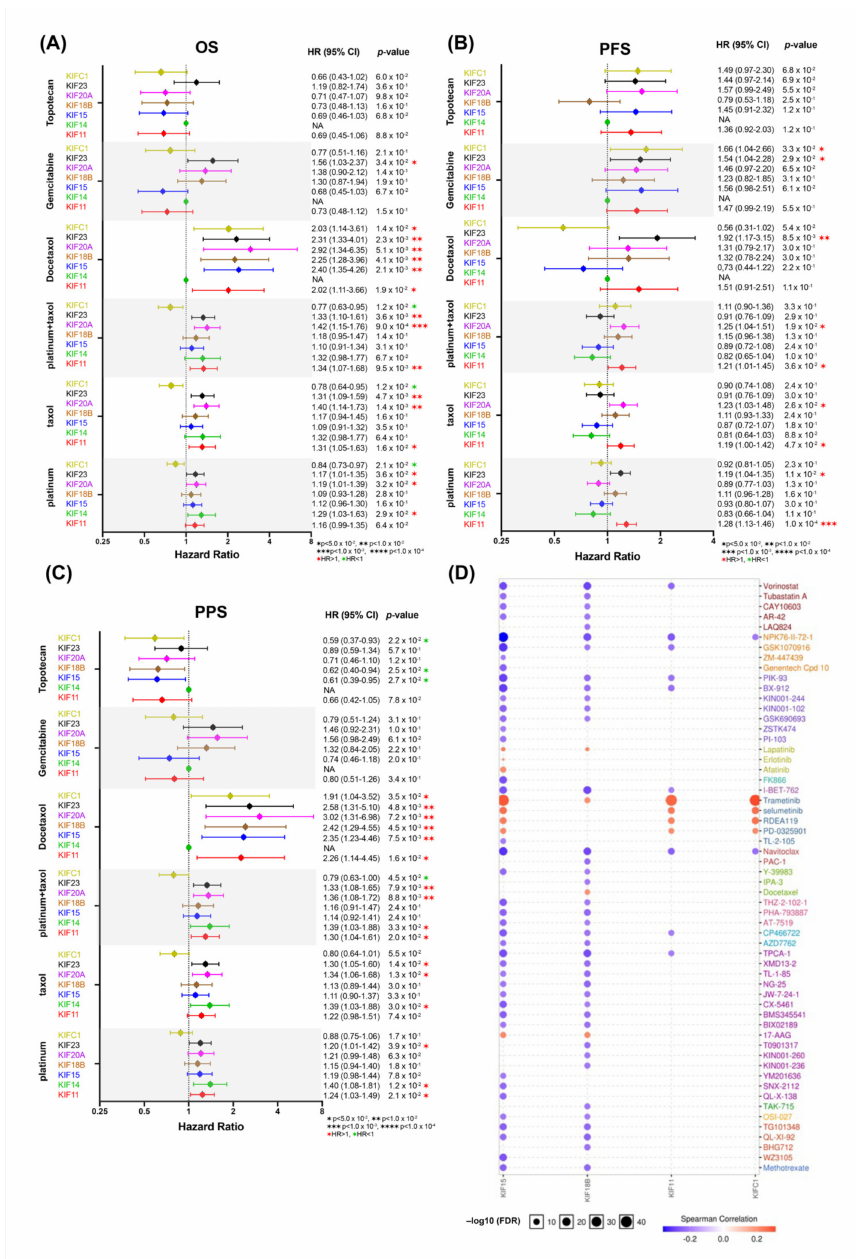
Figure 7. Prognostic values of ten overexpressed mitotic KIFs in OC chemotherapies. Forest plots of relationship between prognosis ( A ) OS, ( B ) PFS, ( C ) PPS, and ten overexpressed mitotic KIFs mRNA expression in patients with different OC chemotherapies using TCGA-OV dataset. ( D ) Drug resistance analyses of overexpressed mitotic KIFs. The expression of each gene was performed by Spearman correlation analysis with the small molecule/drug sensitivity (IC50). The positive correlation means that the gene high expression is resistant to the drug and vice